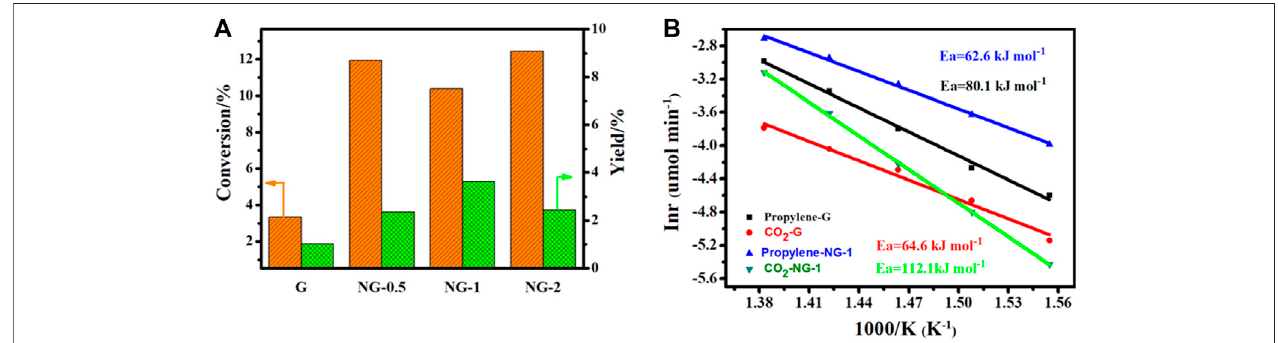
FIGURE4|(A) ConversionofpropeneandpropyleneyieldfordifferentcatalystsinODHreaction. (B) ArrheniusplotsandapparentactivationenergyforGandNG- 1. (reaction conditions: 40 mg catalysts, 4% propane, ambient pressure, 15 ml/min, He balance, 400 – 450 ° C.